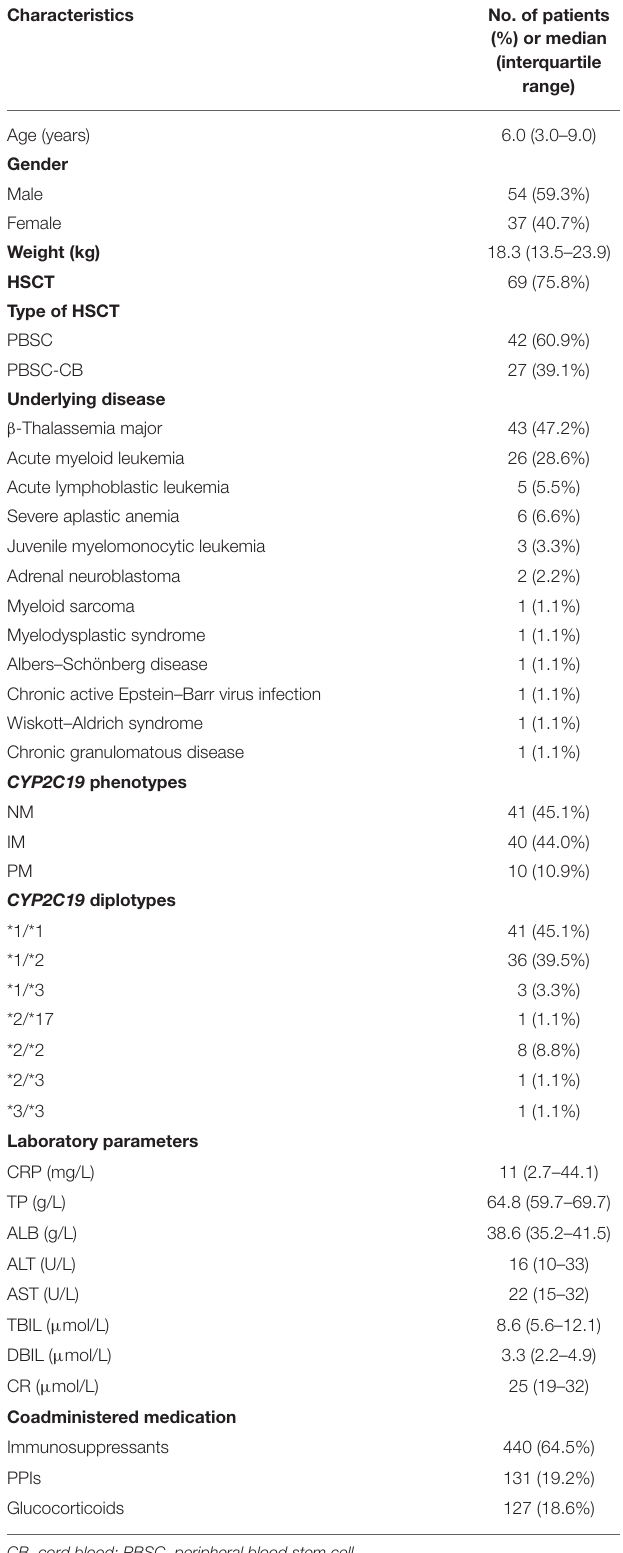
TABLE 1 | Demographic and clinical characteristics of the study subjects ( N = 91).